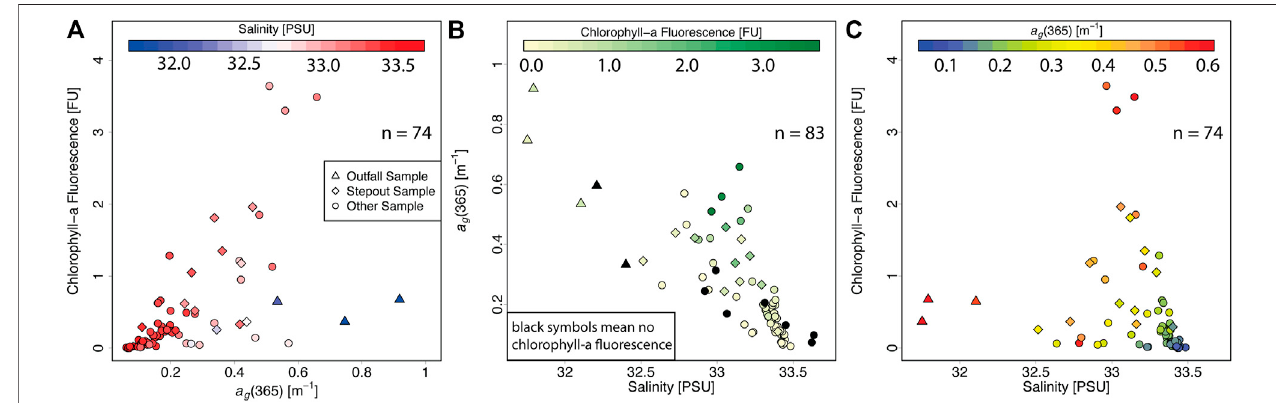
FIGURE 3 | Comparison of in-situ environmental parameters measured during the fi eld campaign: (A) a g (365) versus chlorophyll-a fl uorescence with color scale indicative ofsalinity, (B) salinity versus a g (365) with color scale indicativeof chlorophyll-a fl uorescence, and (C) salinity versus chlorophyll-a fl uorescence with color scale indicative of a g (365). In situ chlorophyll-a fl uorescence was not measured at all stations (black symbols in panel B do not have chlorophyll-a